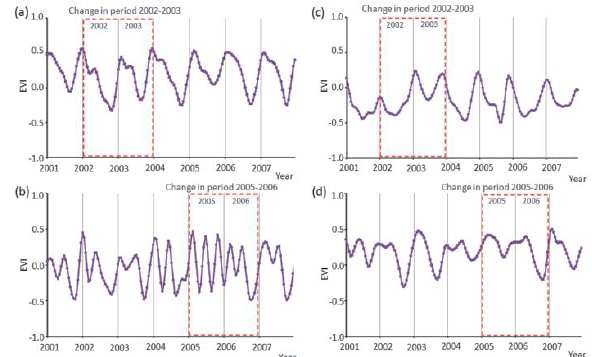
Figure 6. Several detected changes from a single MODIS pixel within agricultural lands that assigned as seasonal/ gradual changes